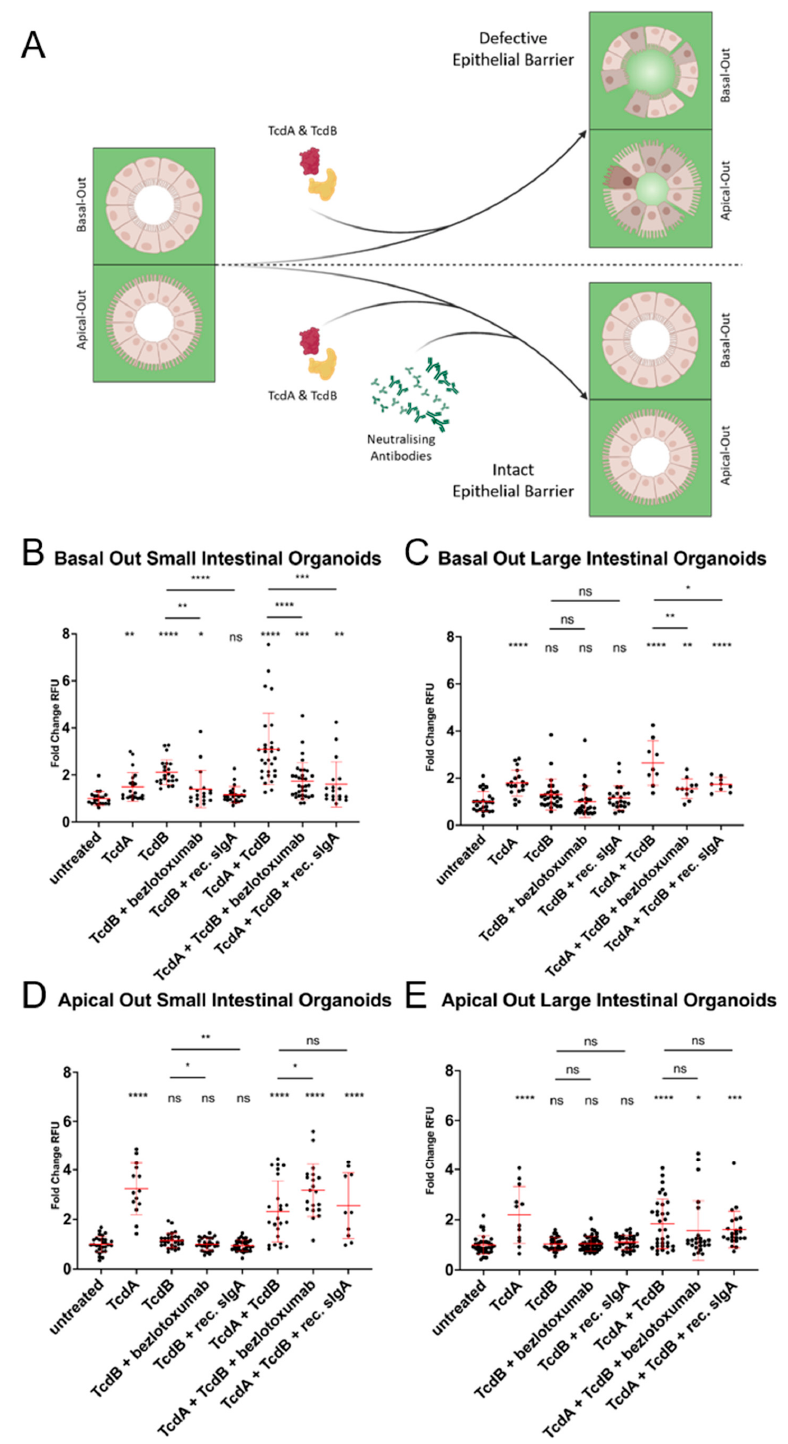
Figure 5. Different effects of TcdA and TcdB on basal-out and apical-out organoids in FITC-dextran barrier integrity assays. ( A ) A scheme representing the experimental approach. Small and large intestinal basal-out ( B , C ) and apical-out organoids ( D , E ) treated with TcdA, TcdB or a combination of both toxins. TcdB and the combination of TcdA and TcdB were pre-incubated with two different antibodies (bezlotoxumab and recombinant sIgA). Student’s t -tests were performed using untreated controls as a reference, if not indicated otherwise. Error bars indicate standard deviations from the arithmetic means. RFU = relative fluorescent units, * p < 0.05, ** p < 0.01, *** p < 0.001, **** p < 0.0001, ns =